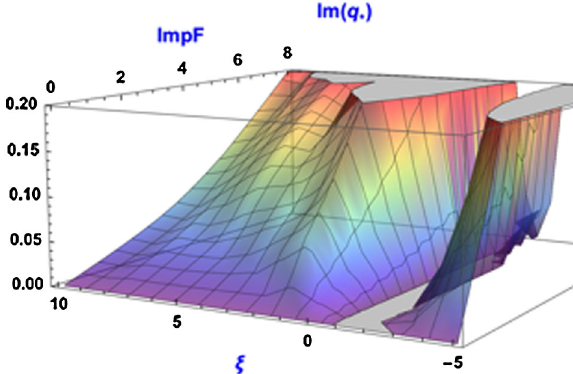
FIG. 18. Same for resistive g ¼ 10